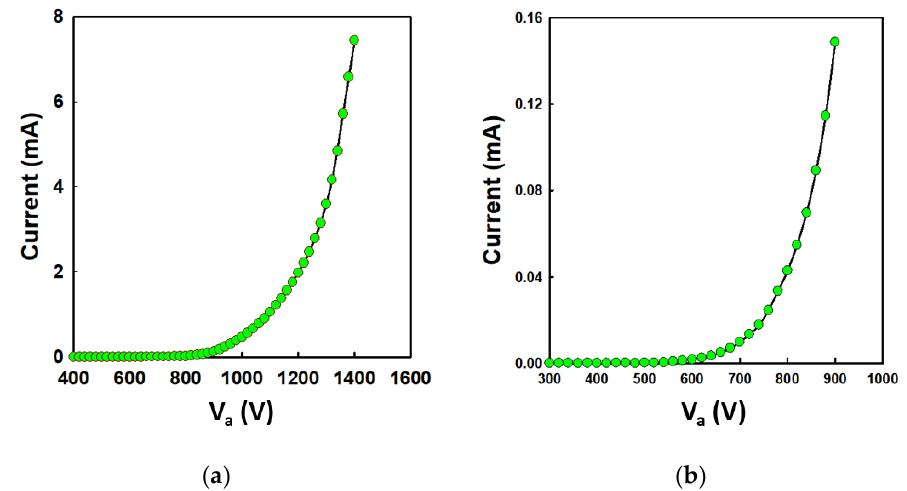
Figure 4. I – V curves of ( a ) 88-island emitter array and ( b ) single-island emitter array in a diode